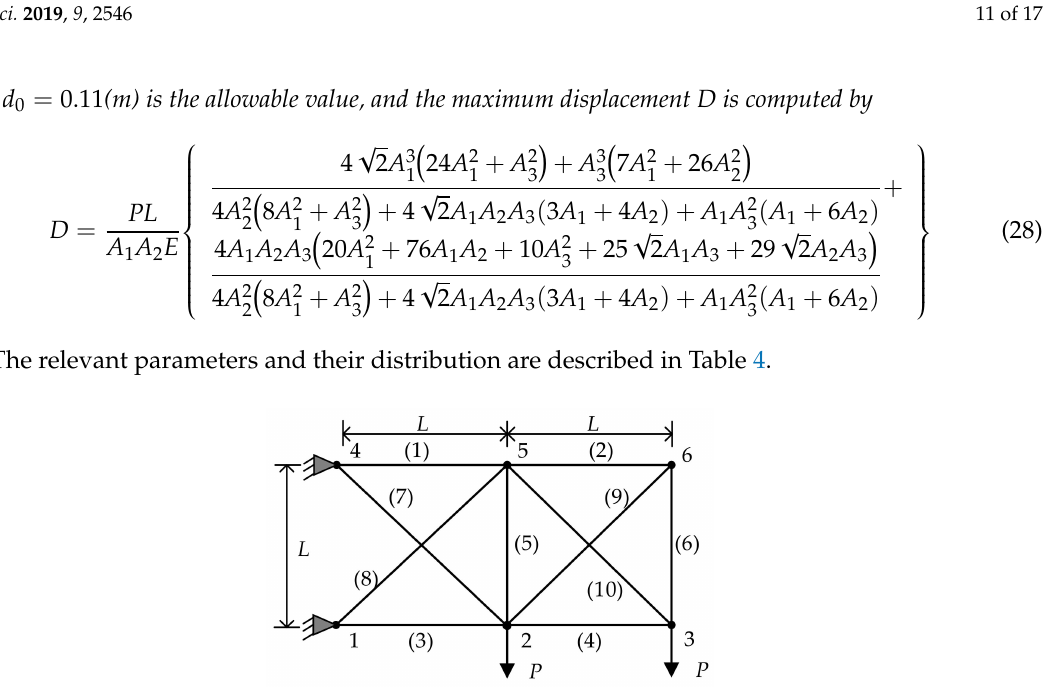
Figure 8. Ten-bar truss structure. Table 4. Statistics of random variables in Example 4.